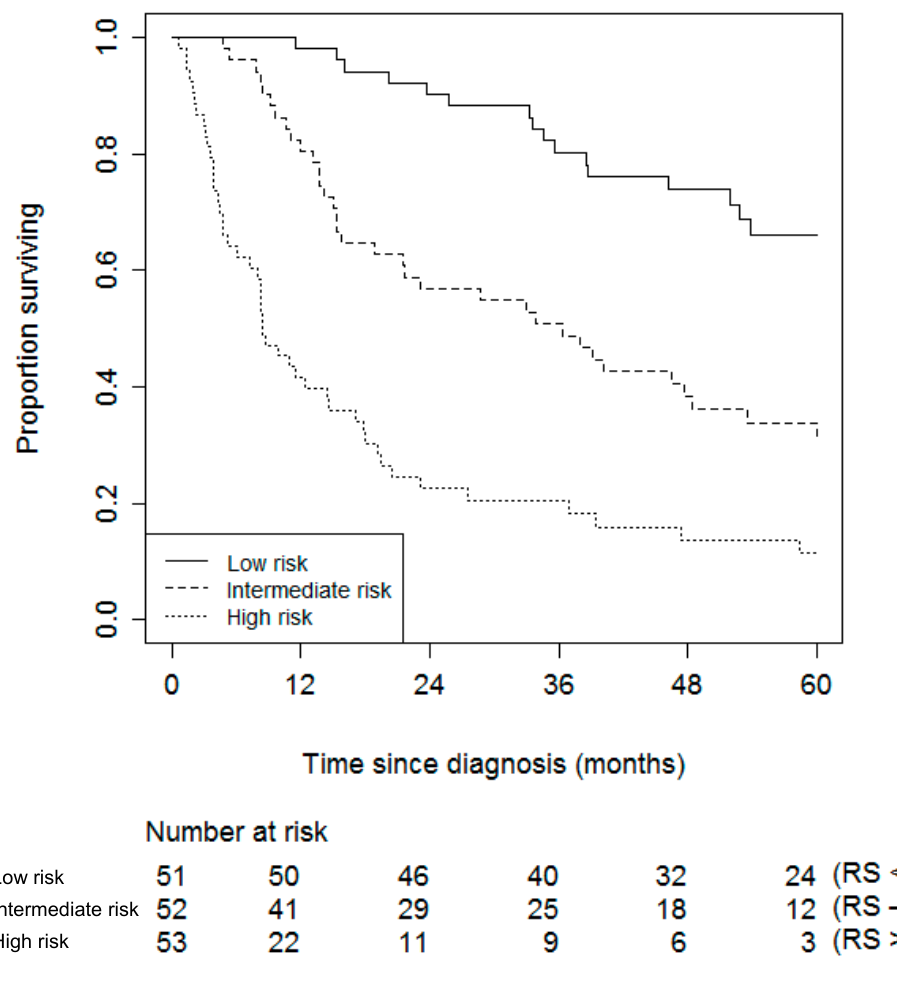
Figure 4. Kaplan–Meier stratified by risk groups based on each individual’s risk score (RS) of the model without Ki67. The Risk Score can be computed as 0.02 × (age − 54.5) + 0.63 × (mENSAT − 3.2) − 0.44 × (radical resection of the tumor − 0.8).